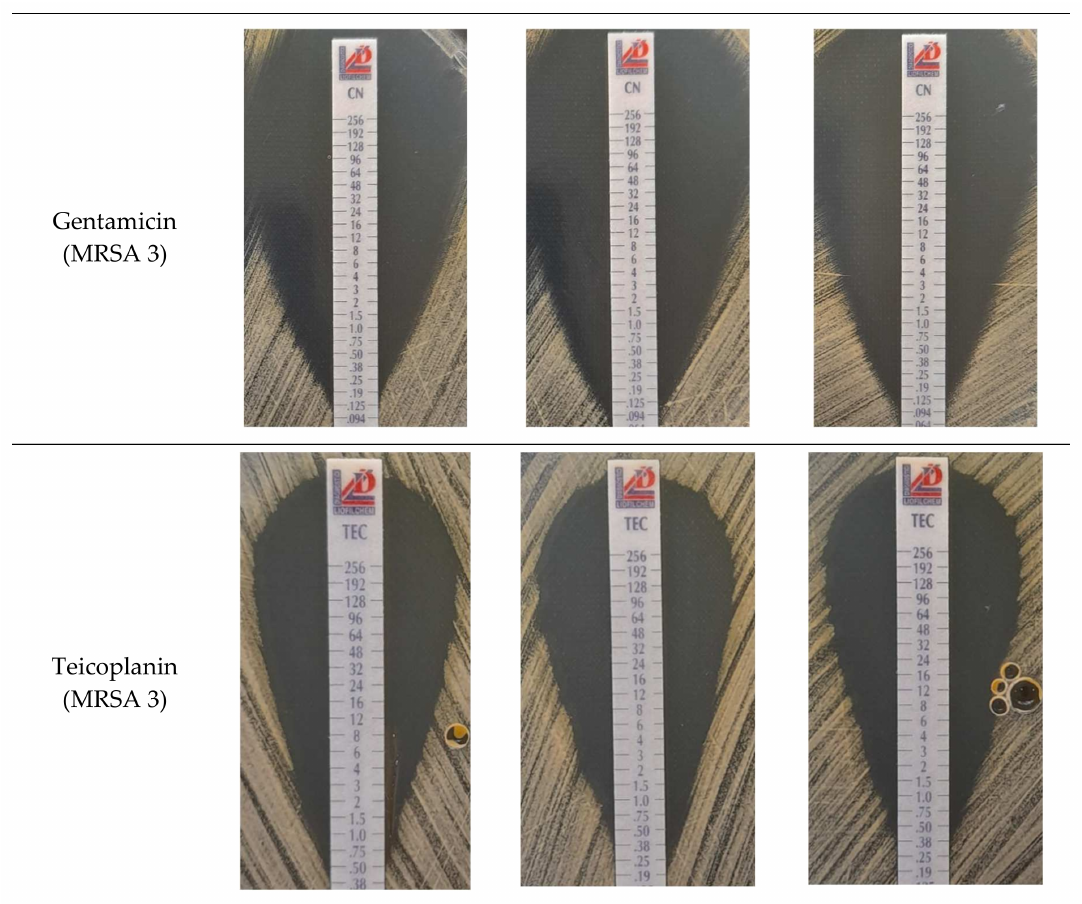
Figure 2. Representative pictures of gradient MIC strips (E-tests) with different antibiotics in control and RMF-exposed cultures of the MRSA strains.